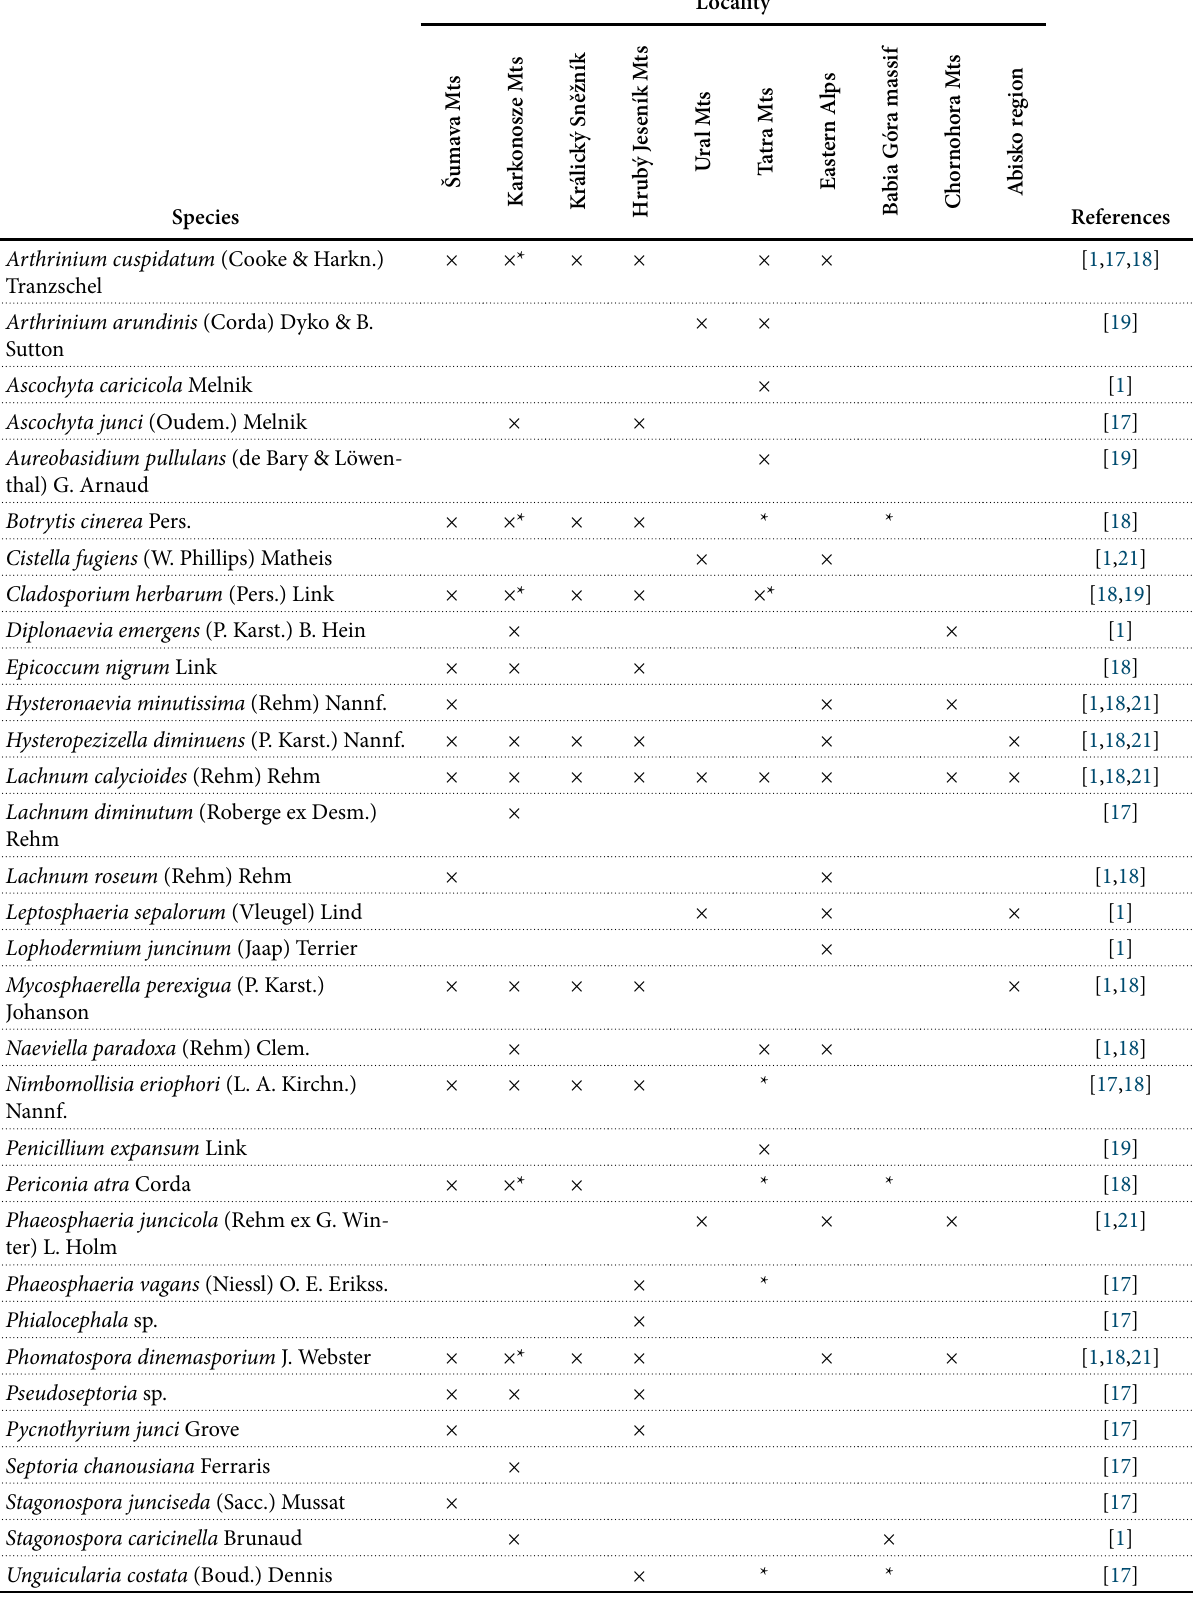
Tab. 6 Fungi species reported on J. trifidus based on own observations and literature